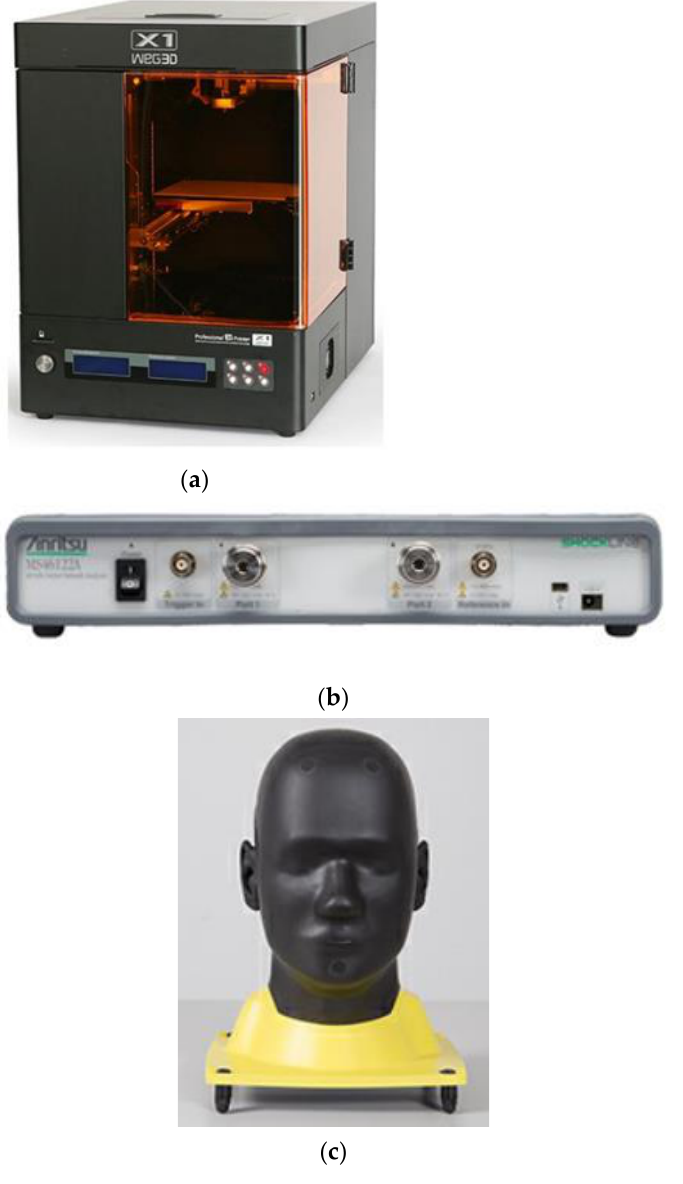
Figure 11. The resource for the tests. ( a ) 3D printer [28]; ( b ) VNA [29]; ( c ) human phantom [30].